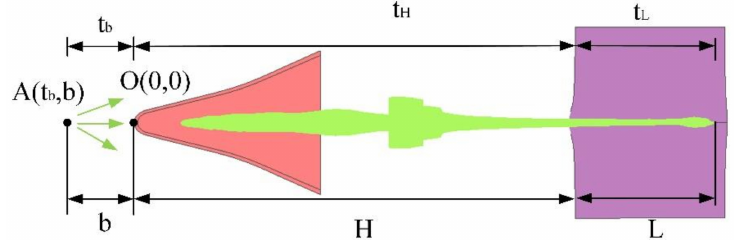
Figure 15. Simplified quasi-steady calculation model of armor-breaking by the